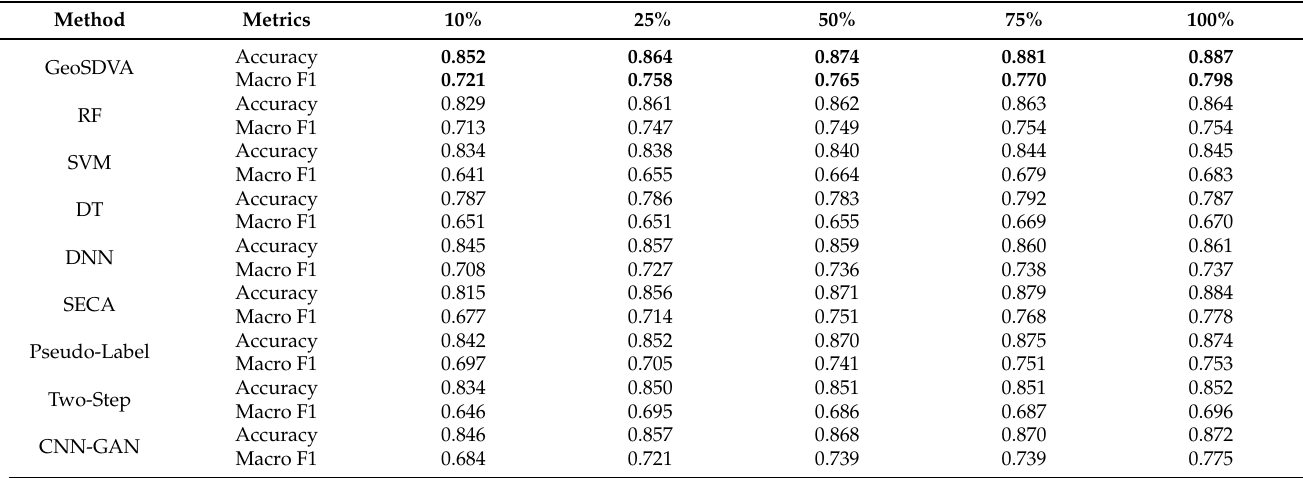
Table 7. The performance of different models on the MTL Trajet 2016